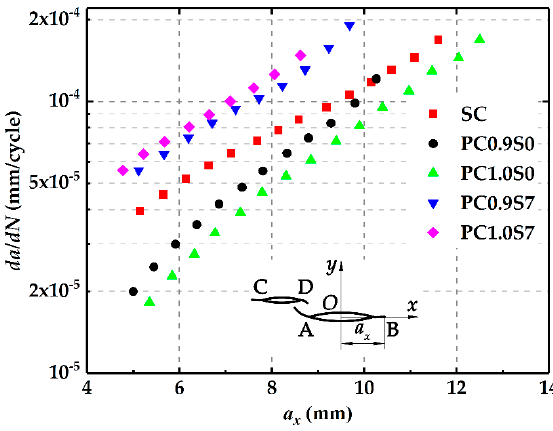
Figure 12. Changes of crack growth rates at tip B with the increasing a x.